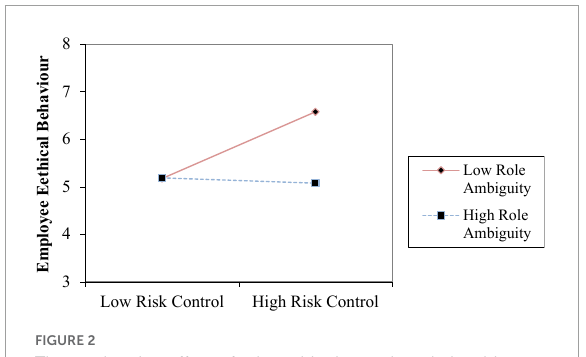
FIGURE2 The moderating effect of role ambiguity on the relationship between risk control and employee ethical behaviors.